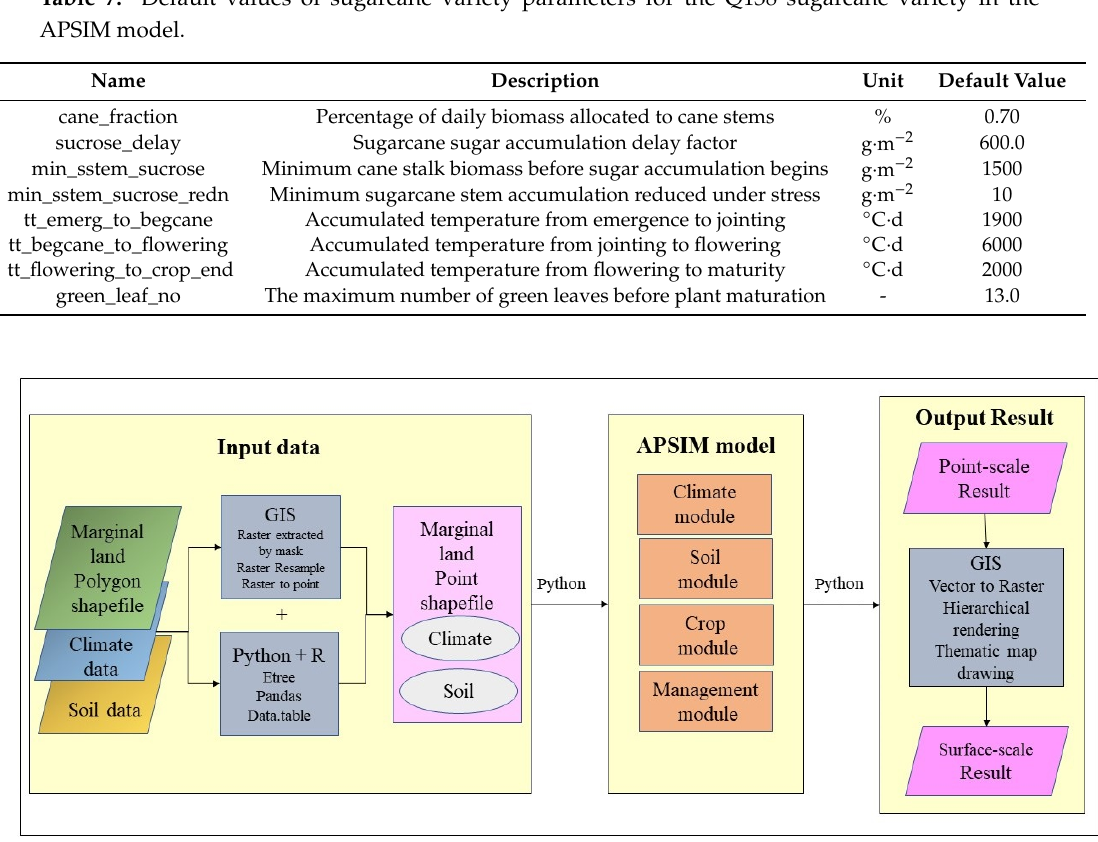
Figure 5. APSIM model spatial expansion technology flow chart.